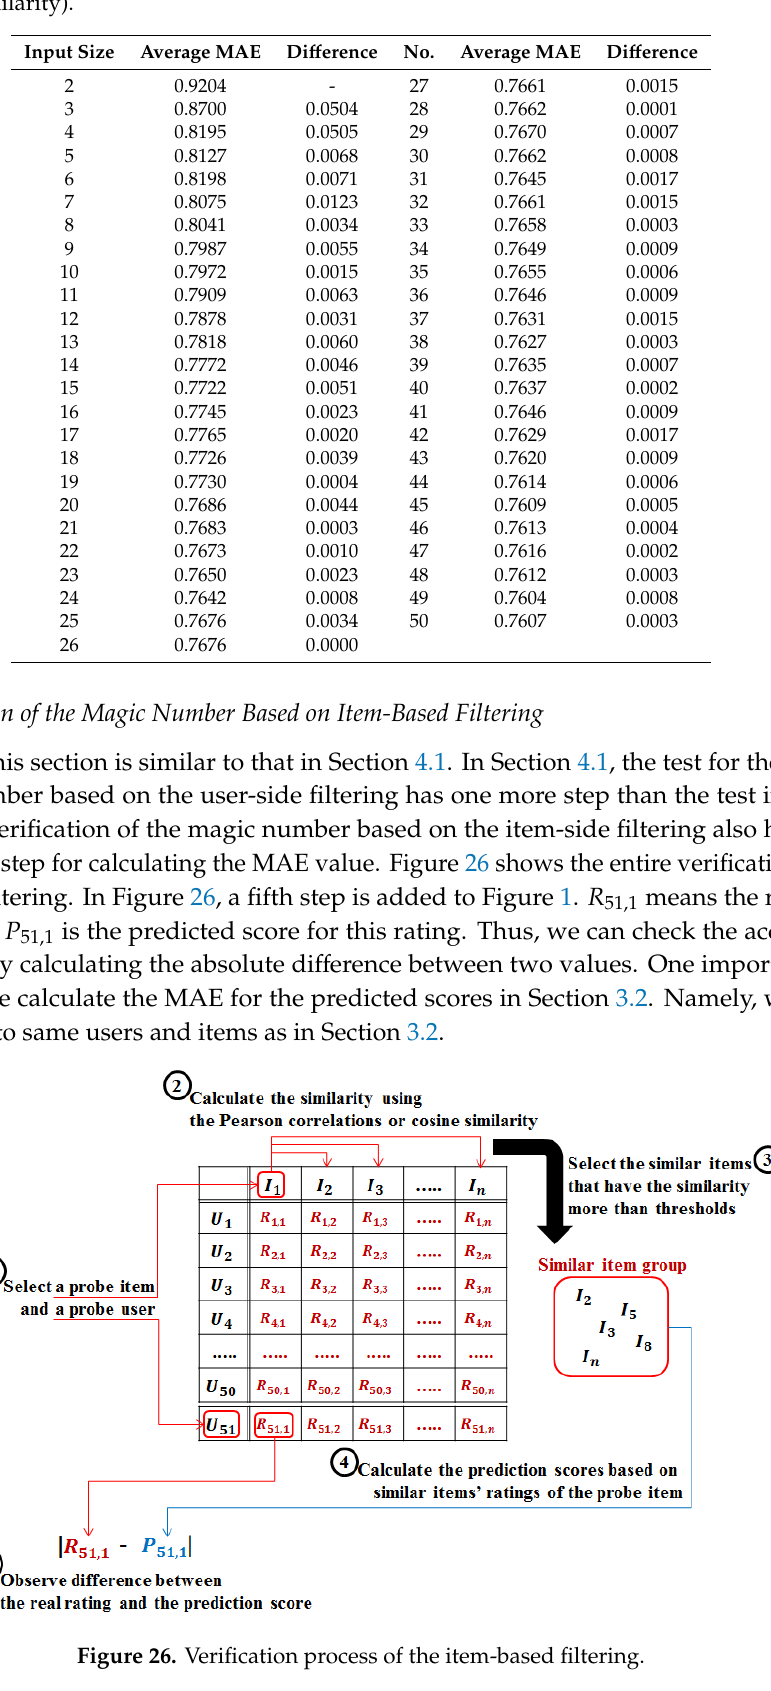
Table 11. Change in the average of MAE and average di ff erence for each range (the user-based filtering: the cosine similarity).